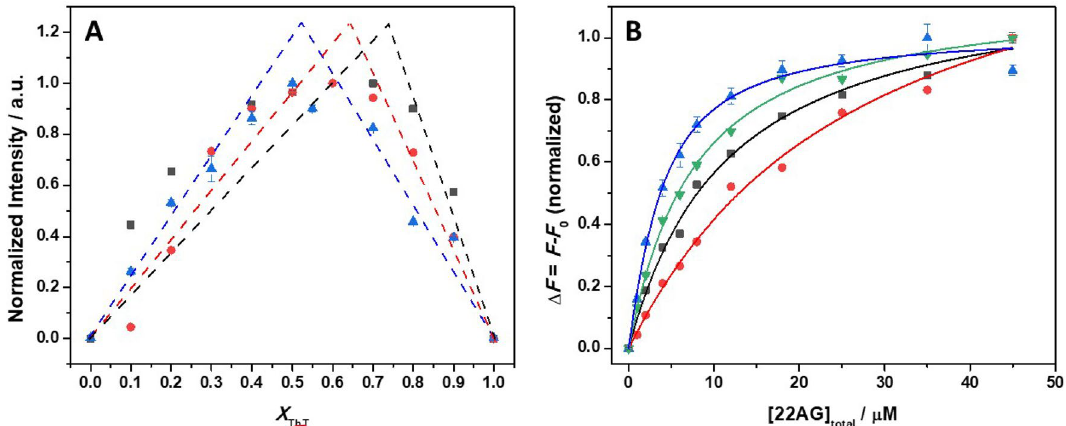
Figure 1. ( A ) Job’s plot for the ThT/22AG system in 30 mM Tris, pH 7.4 (black squares) and in the same buffer with 25 wt% Ficoll (red circles) and in the presence of 60 mM NaCl (blue triangles). For comparison, the dashed lines represent the positions of 1:1, 1:2 and 1:3 (22AG:ThT) complexes in an ideal case where only one type of complex is present in solution. ( B ) Binding isotherms for the titration of a 2.14 µM ThT solution with a solution of 22AG in 30 mM Tris, pH 7.4 (black squares), in the same buffer with the addition of 60 mM NaCl (red circles), in the presence of 60 mM KCl (blue triangles), and in the presence of 25 wt% Ficoll (green reversed triangles). To be able to compare these data, the binding isotherms were normalized. All the experiments were carried out in triplicate at ambient conditions ( p = 1 bar and T = 25 °C). Where not shown, the error bars are smaller than the symbol size. Solvent K b /M −1 ∙10 5 22AG:ThT stoichiometry 30 mM Tris, pH